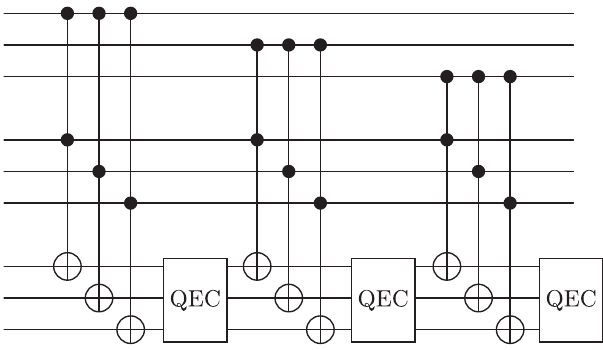
FIG. 8. Pieceable fault-tolerant Toffoli circuit. Each block of n ¼ 3 cat qubits represents one repetition cat